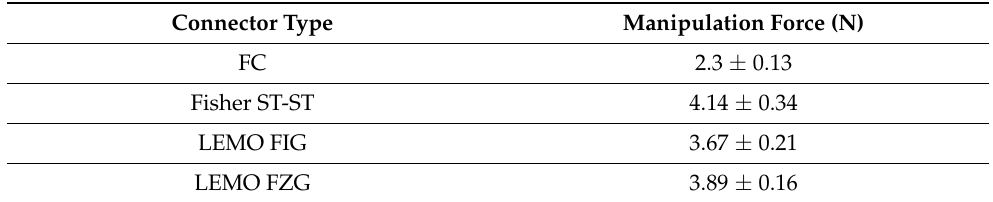
Table 1. Force reference to plug in and unplug in the reported